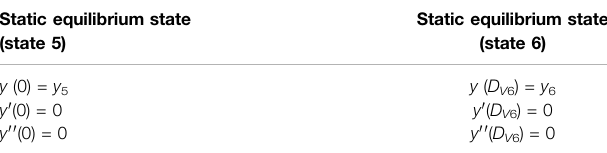
TABLE 7 | Return phase conditions (vertical